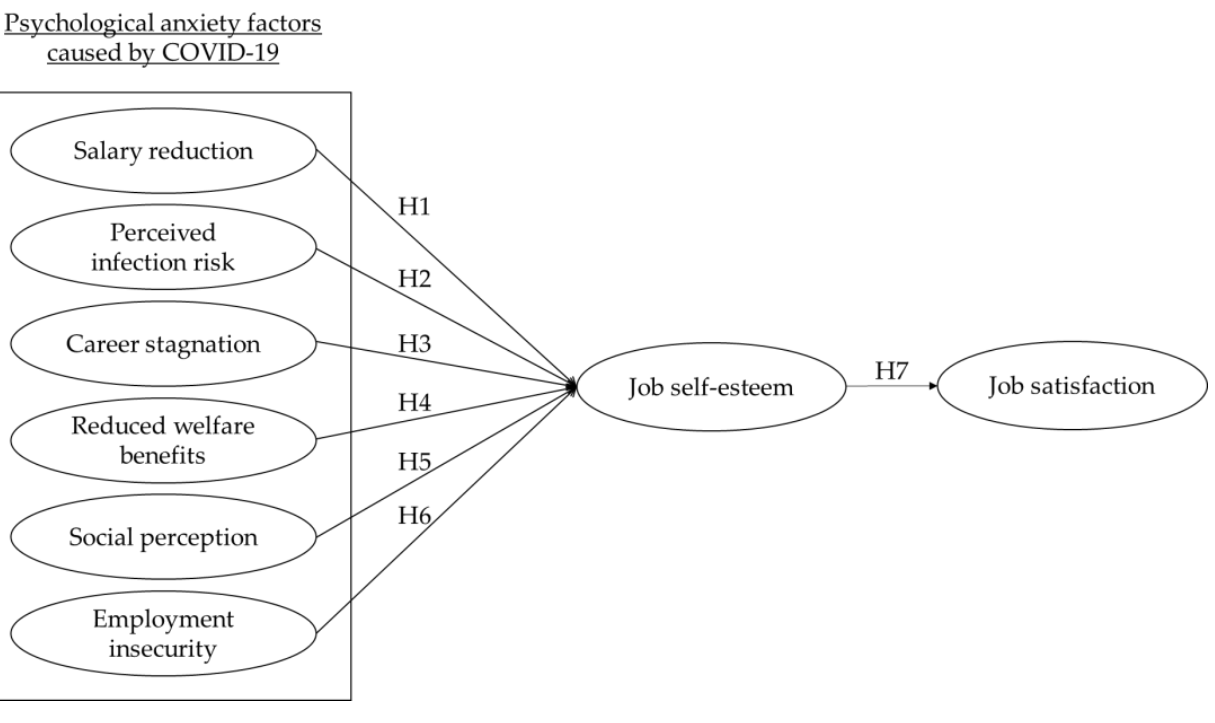
Figure 1. Research model.